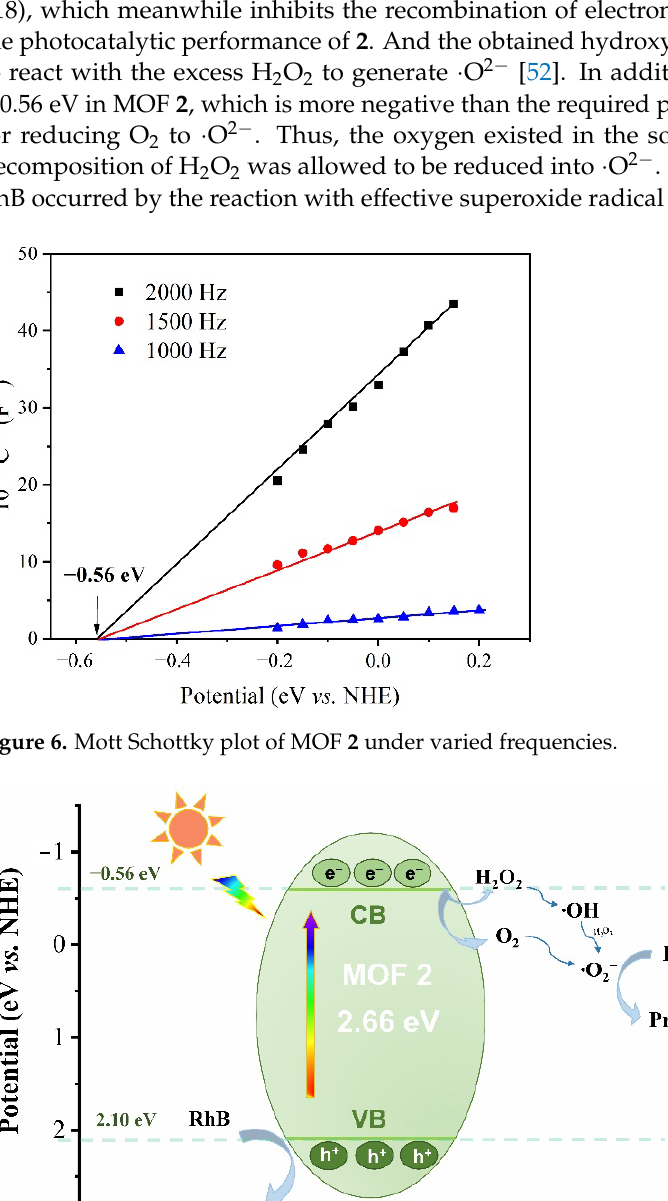
Figure 7. Possible mechanism of photodegradation of RhB by MOF 2 and H 2 O 2 .